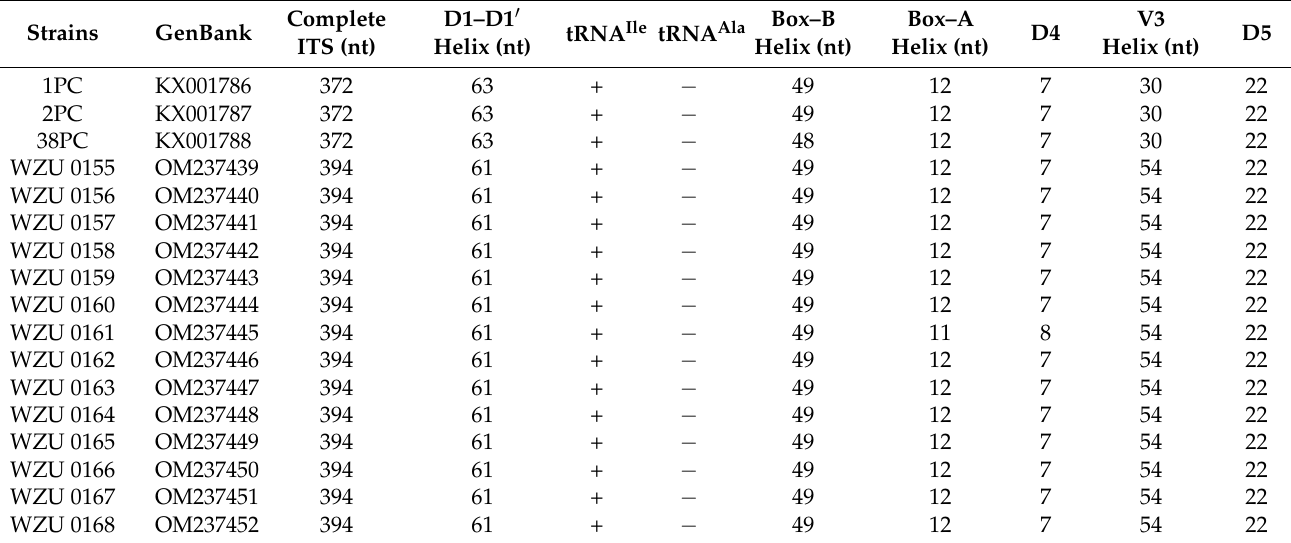
Table 3. Analyses on ITS of 16S–23S region for Potamolinea aerugineocaerulea